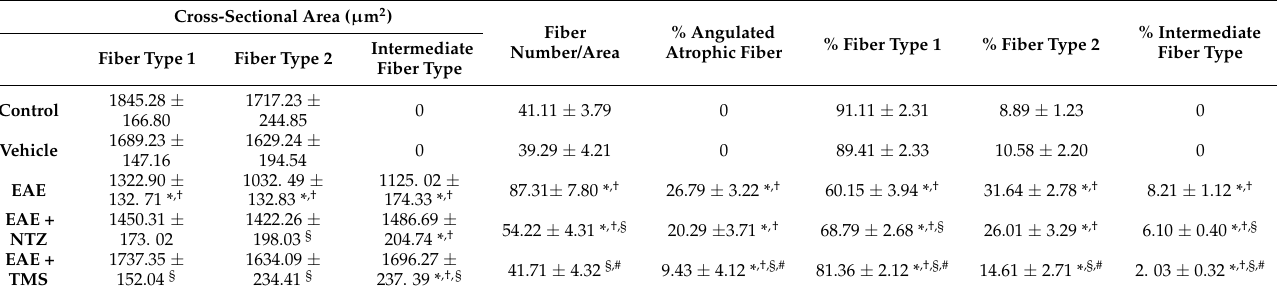
Table 5. Histomorphometric parameters of soleus